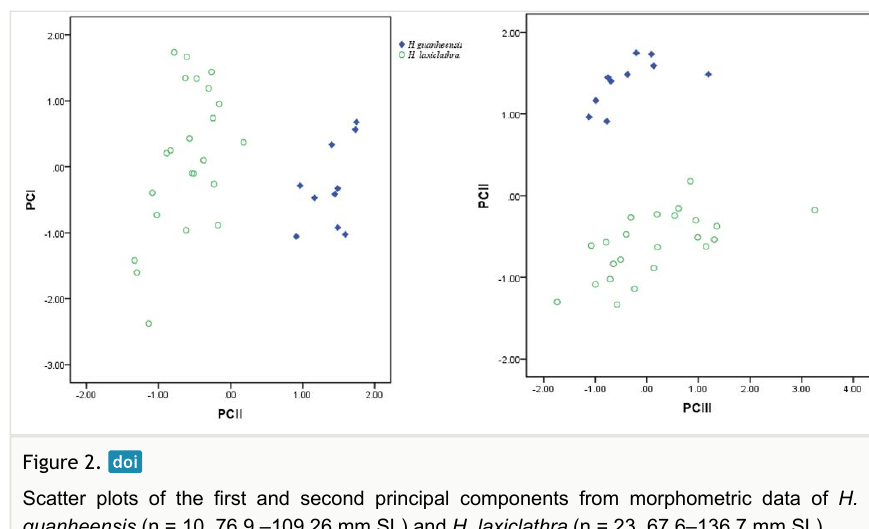
Figure 2. Scatter plots of the first and second principal components from morphometric data of H. guanheensis (n = 10, 76.9 –109.26 mm SL) and H. laxiclathra (n = 23, 67.6–136.7 mm Color in preserved specimens (fixed in 10% formalin): Head and body brown; a series of 19–22 body bars, each bar at least twice as wide as the interspace. Abdomen yellowish. Dorsal fin with two dark brown marks, one at the base, the other at postmedian of the fin; posterior border of dorsal fin white. Pectoral fins with dark brown spots. Pelvic and anal fins white, dark at the base. Adipose keels white with dark brown spots. Caudal fin dark grey; brown vertical bars on caudal fin base (Fig. 1). Diagnosis Homatula guanheensis is different from its congeners in the following characters: partly scaled (vs. in the latter, scales are totally absent or only a few scales on the caudal peduncle in H. nanpanjiangensis , H. oligolepis , H. disparizona and H. wenshanensis vs. scales all over the body, except for the head in H. acuticephala , H. anguillioides , H. pycnolepis , H. wuliangensis , H. change and H. coccinocola ); complete lateral line (vs. incomplete lateral line in H. potanini and H. wujiangensis ); the vertical brown bars on the body are wider than their interspaces, numbering 19–22 (vs. equal to interspace or slightly wider than its interspace in H. variegate , H. berezowskii and H. longidorsalis ); caudal fin micro-rounded (vs. truncated or oblique in H. variegata and H. berezowskii ); adipose crest on caudal peduncle not reaching forward of the position of the anal-fin origin (vs. beyond in H. variegate vs. identical in H. longidorsalis ); predorsal body partially scaled (vs. absent scales in H. berezowskii and H. longidorsalis ); anterior nostril forming a valve (vs. forming a spool in H. longidorsalis ). The vertical brown bars on the body of the new species are similar to H. laxiclathra . The new species can be further distinguished from H. laxiclathra in that the intestine forms a bend, not reaching the posterior surface of U-shaped stomach (vs. a loop anteriorly reaching the posterior surface of the U-shaped stomach); anterior with only a few and scattered scales (vs. scaleless).